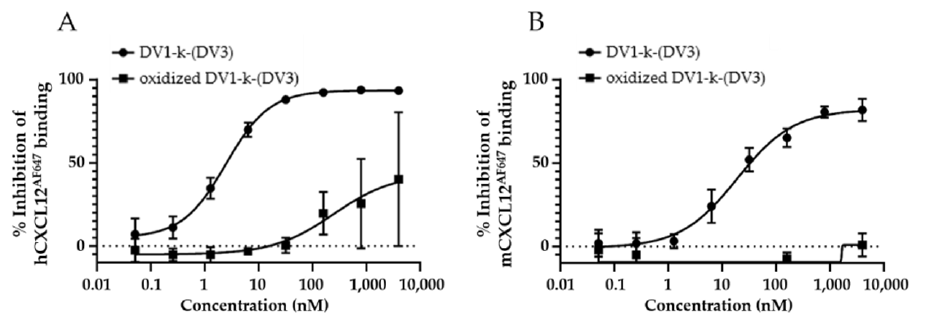
Figure 6. Binding affinities of DV1-k-(DV3) and oxidized DV1-k-(DV3) as reference to hCXCR4 ( A ) and mCXCR4 ( B ). Affinities for hCXCR4 were determined using Jurkat cells and human CXCL12 AF647 as fluorescent ligand. Affinities for mCXCR4 were determined using U87.mCXCR4 and murine CXCL12 AF647 as fluorescent ligand. All data are expressed as mean ± SD ( n = 3).